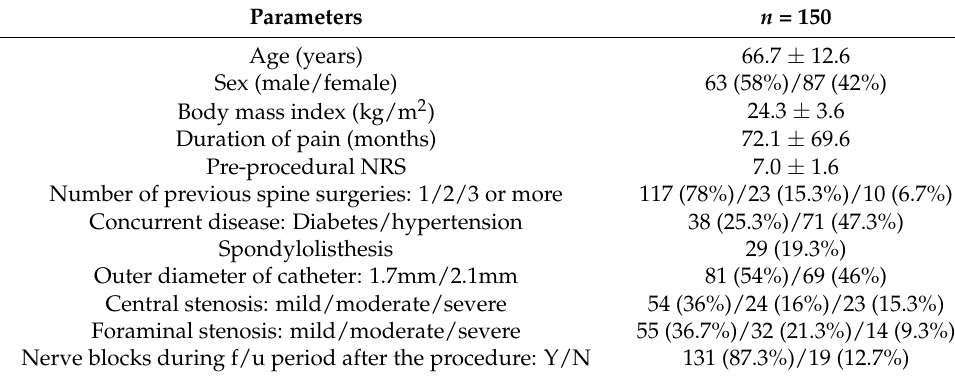
Figure 2. Schematic diagram of the study protocol. Table 1. Baseline demographic